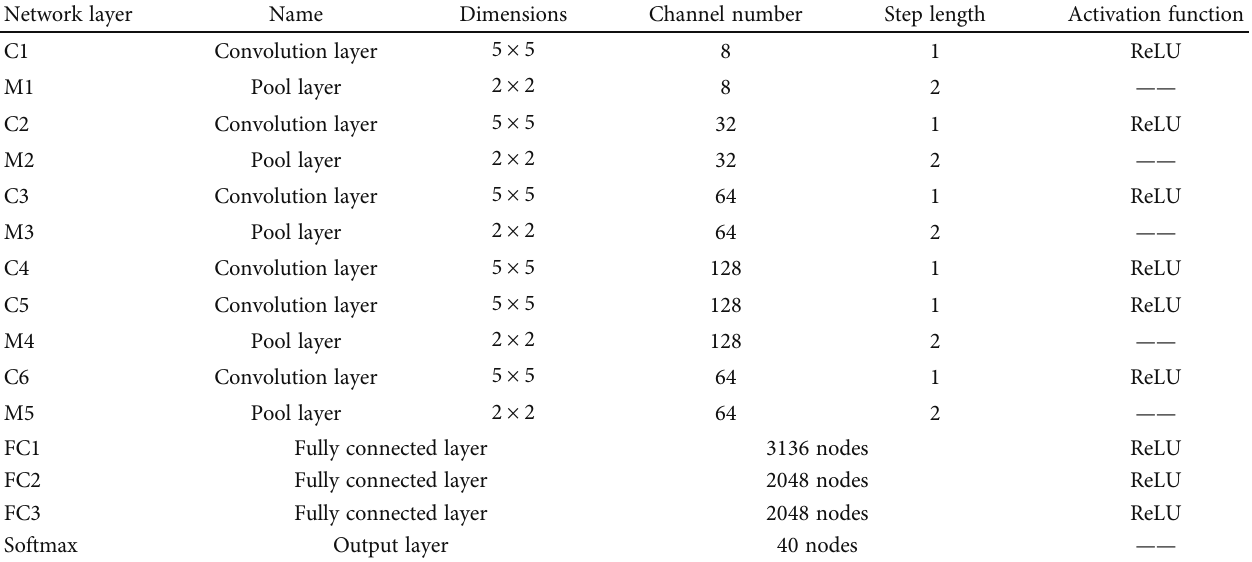
Table 1: Information of all network